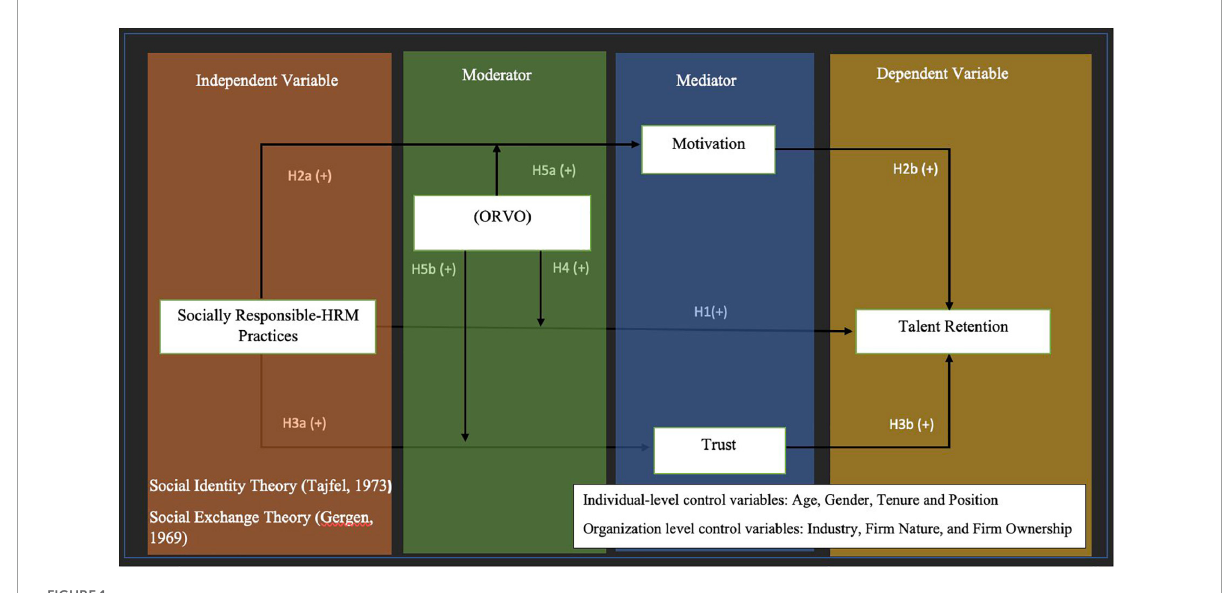
FIGURE1 The conceptual